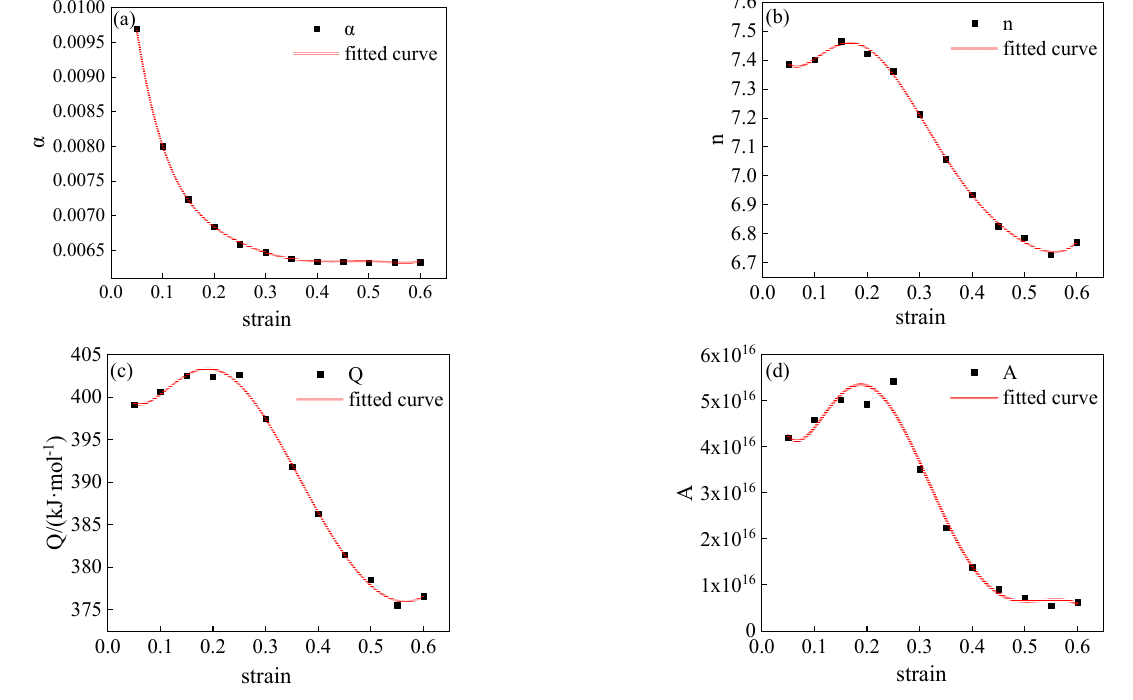
Figure 9. The fitting relationship curve between strain and material parameters: ( a ) α - ε ; ( b ) n- ε ; ( c ) Q- ε ; ( d ) A- ε . Table 5. Polynomial coefficients of material